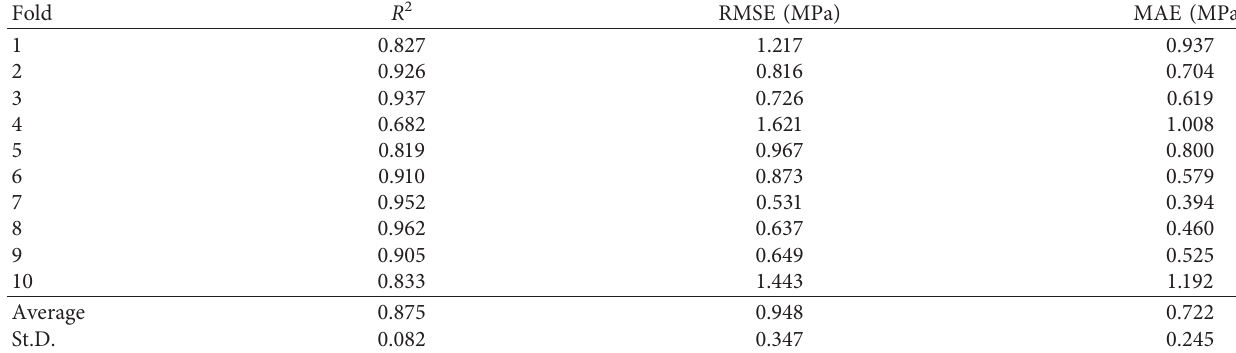
Table 4: 10-fold cross-validation statistic